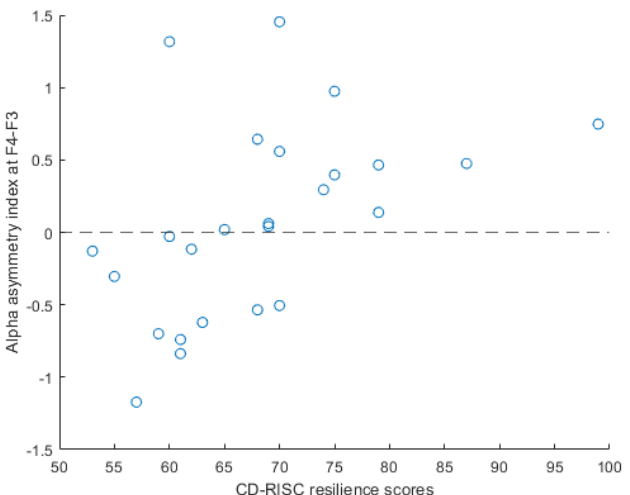
Figure 5. Relationship between CD-RISC scores and the averaged alpha asymmetry index during task conditions (task averaged : rho = 0.49, p = 0.01). Participants with lower scores are observed to have negative alpha asymmetry index at